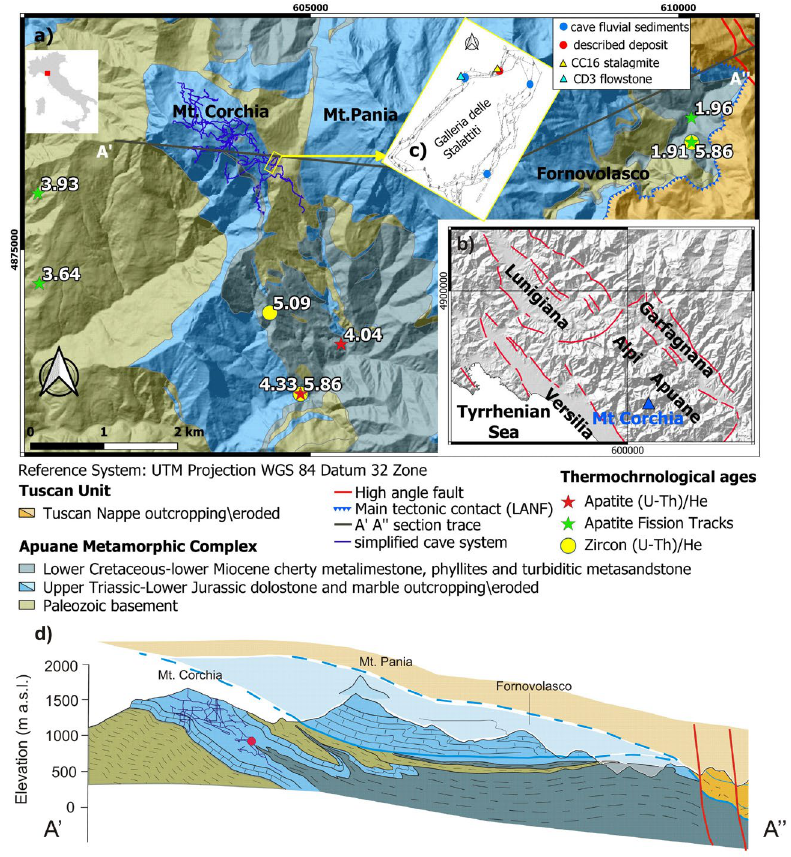
Figure 1. ( a ) Location and geology of the study area ([39] modified). Red and green stars and yellow circles represent the location of samples used for Apatite (U-Th)/He, apatite fission tracks, and Zircon (U-Th)/He thermochronology ages, respectively [8]. ( b ) Simplified tectonic sketch of the Garfagnana and Lunigiana valleys. ( c ) Galleria delle Stalattiti plan map ([40] modified). Circles and triangles show the location of fluvial and calcite deposits, respectively. ( d ) Geological cross section between A’ and A”. Dashed and continuous blue lines represent low-angle normal faults (LANFs) (former thrusts reactivated as LANFs: see [3,41] for further tectonic information). The red dot represents the Galleria delle Stalattiti (GdS)